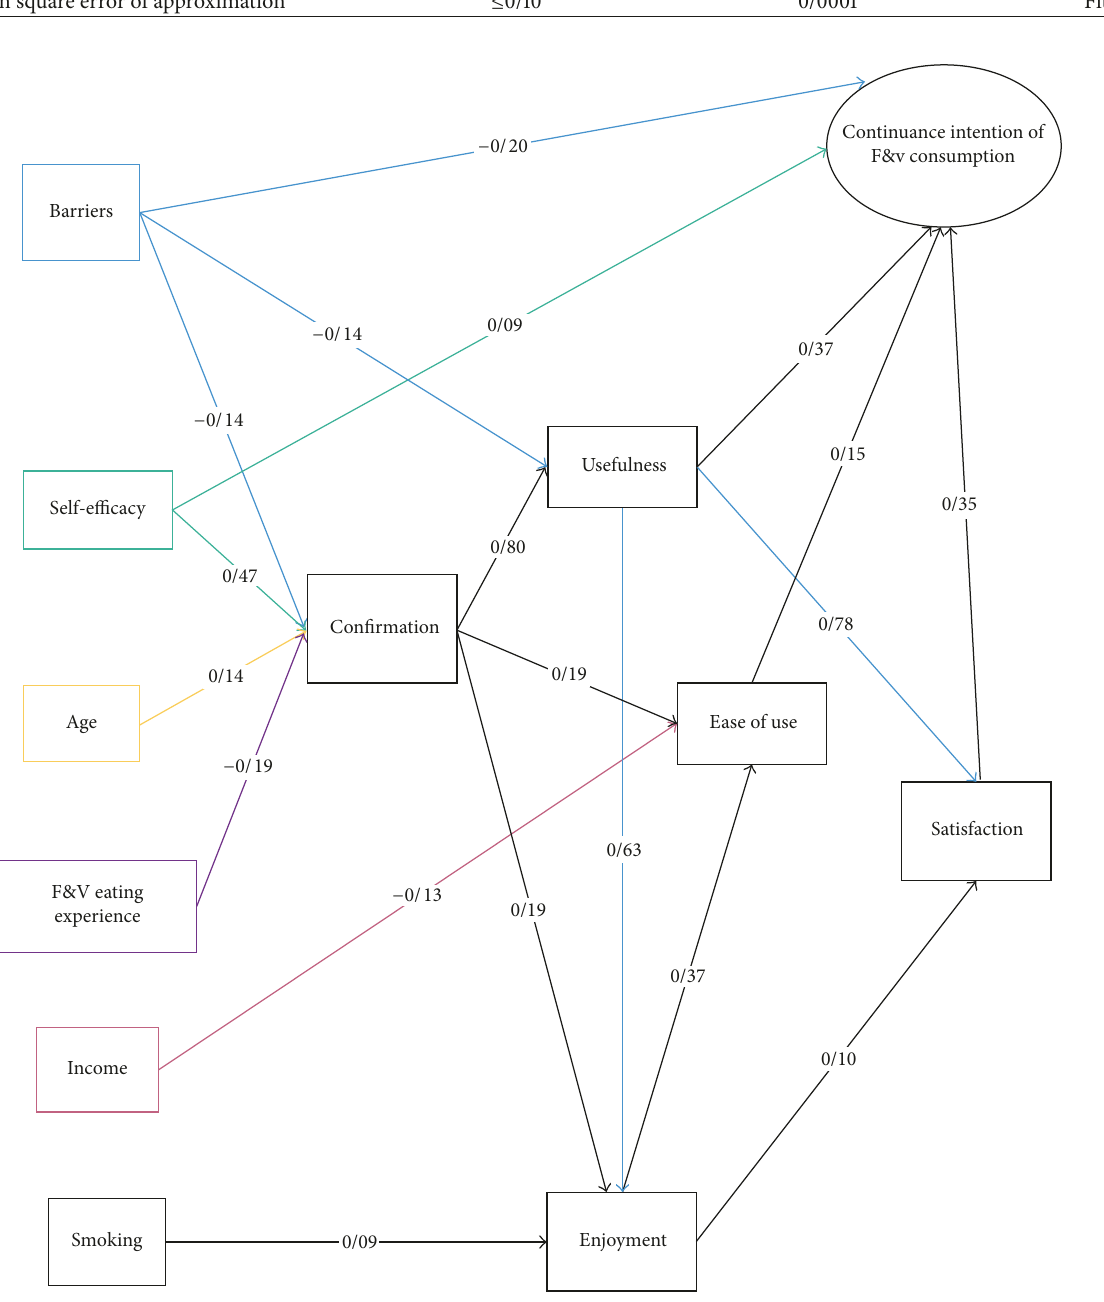
Figure 2: Final model of ECM for continuance intention of consuming F&V among the